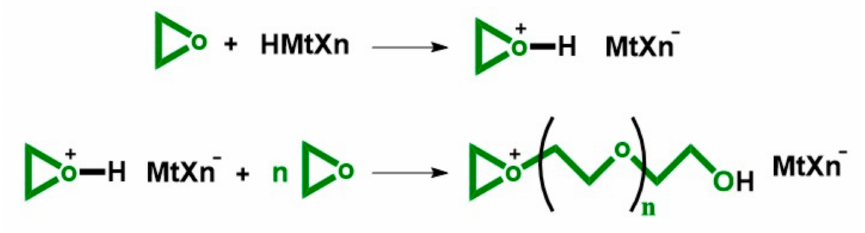
Figure 1. Mechanism of the cationic ring opening polymerization of epoxide.